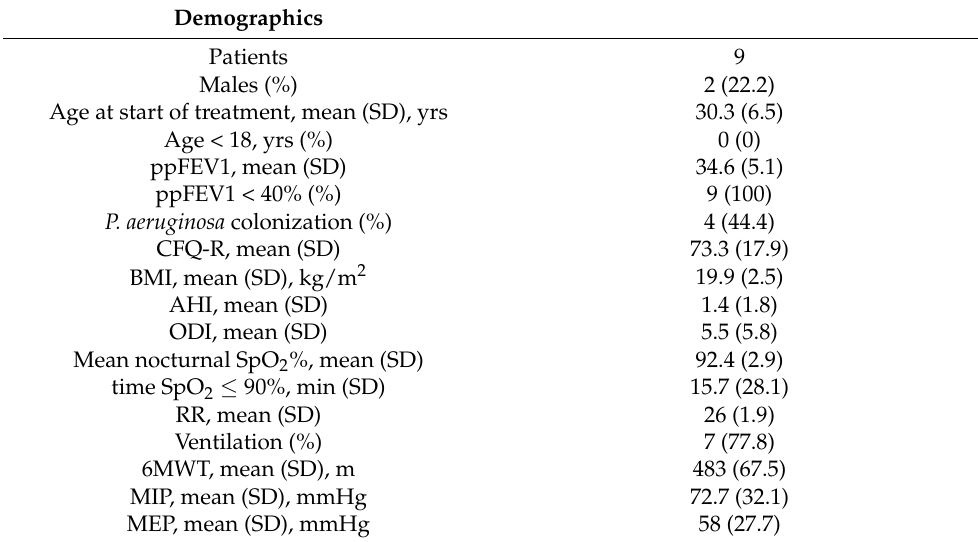
Table 1. Demographic and mean baseline patients’